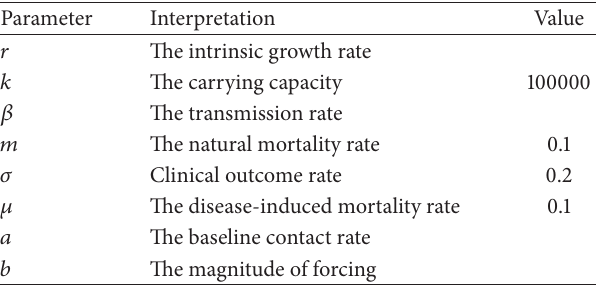
Table 1: Descriptions and values of parameters in model